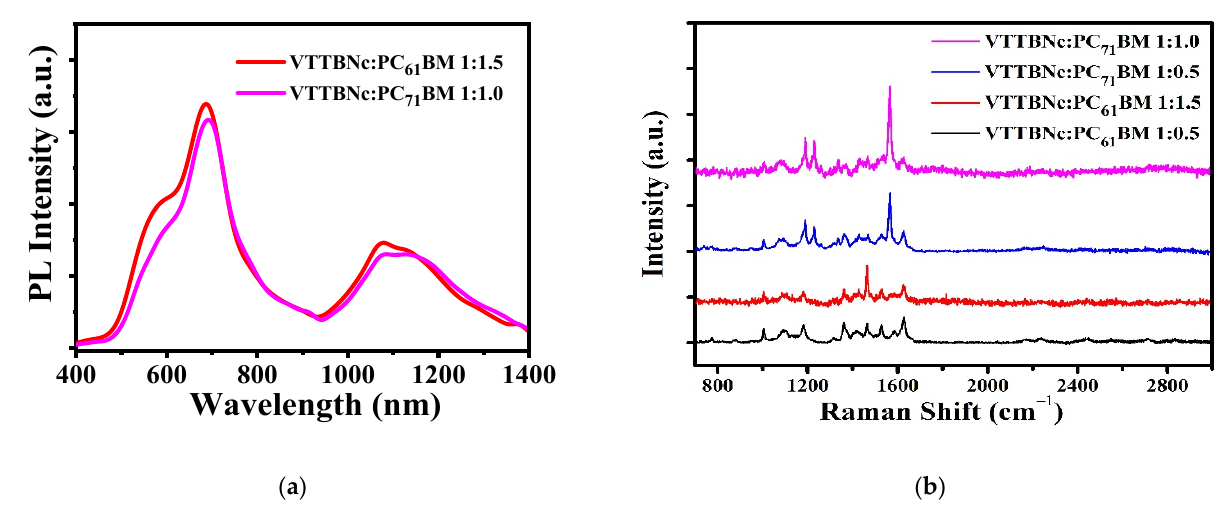
Figure 10. ( a ) Photoluminescence spectra of VTTBNc:PC 61 BM 1:1.5 and VTTBNc:PC 71 BM 1:1.0. ( b ) Raman spectra of VTTBNc:PC 61 BM and VTTBNc:PC 71 BM. Table 4. Raman shifts of VTTBNc:PC 71 BM and VTTBNc:PC 61 BM.